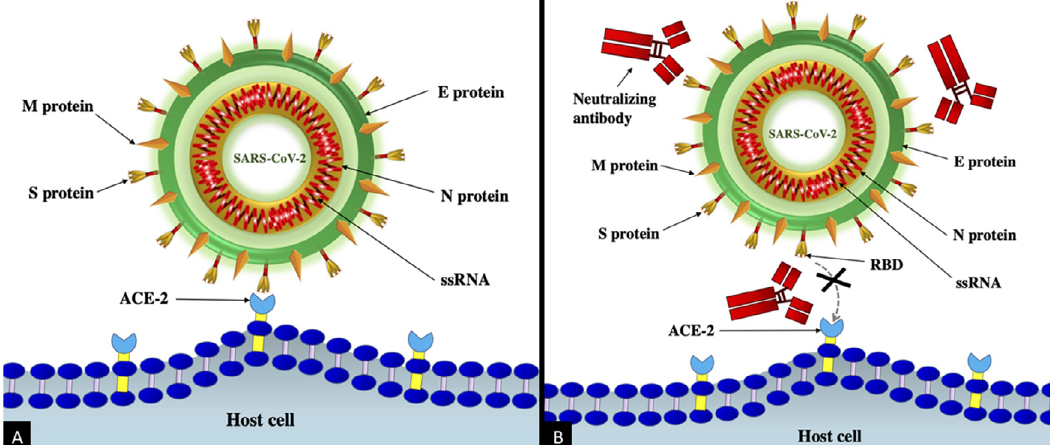
Figure 2. Schematic representation of the SARS-CoV-2 S protein binding with the ACE-2 receptors of host cells with no neutralizing antibodies in sera (Figure 2A), while circulating neutralizing antibodies against the SARS-CoV-2 S protein prevent binding and internalization of the SARS-CoV-2 (Figure 2B)